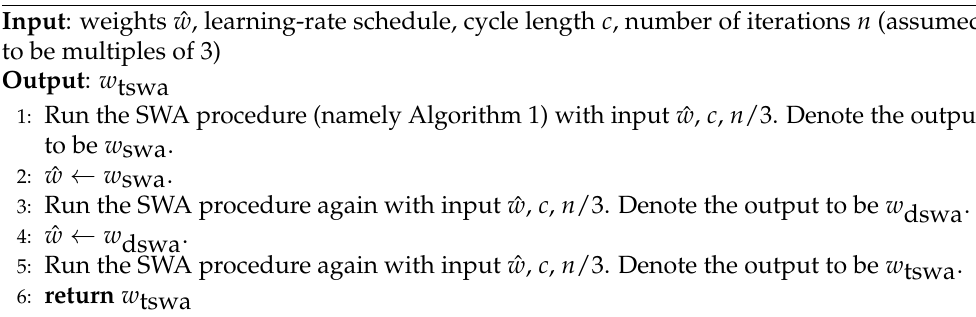
Algorithm 3 Triple Stochastic Weight Averaging